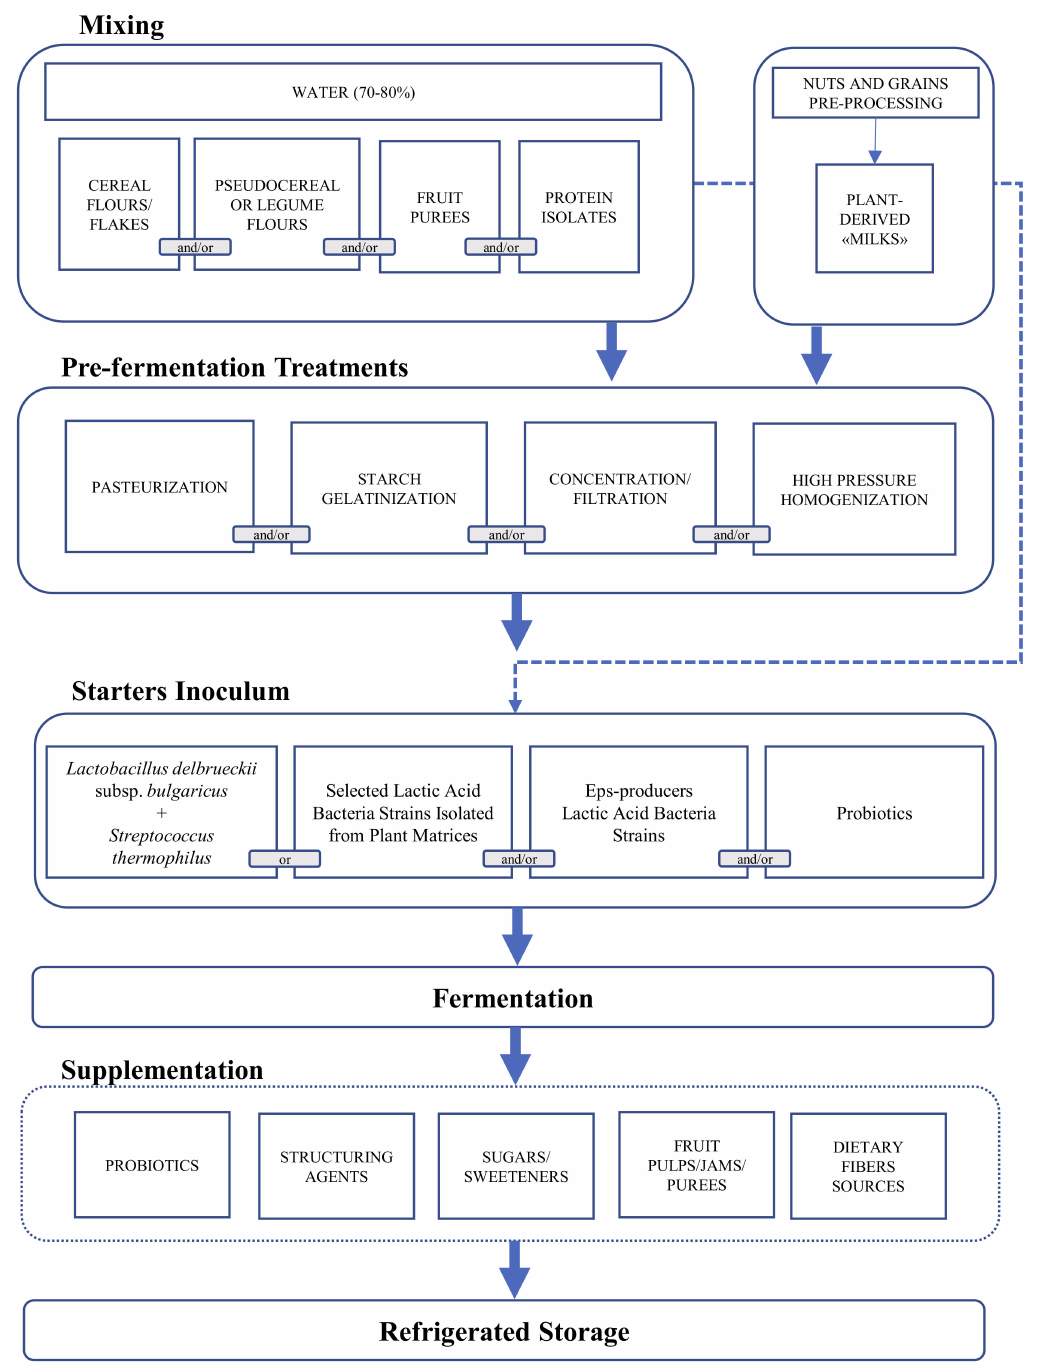
Figure 1. Flow chart of the plant-based yogurt-like production including the biotechnological options proposed by the recent scientific